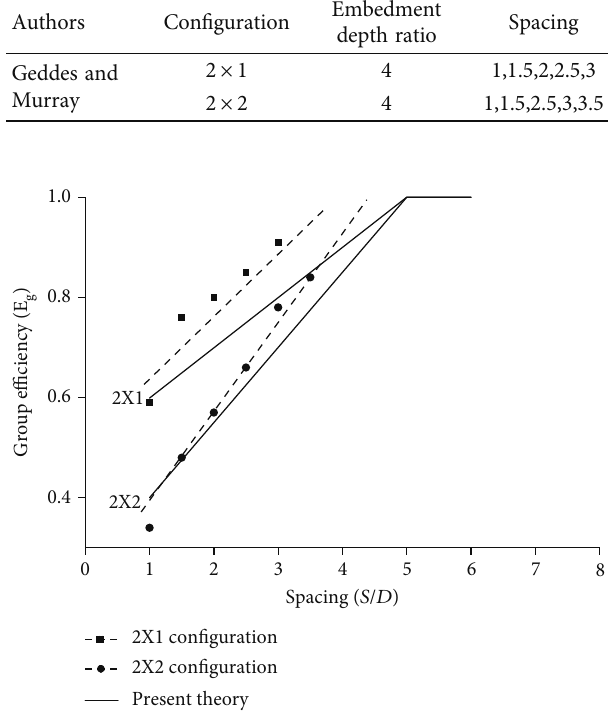
Figure 13: Comparison of the theoretical and experimental variation of group e ffi